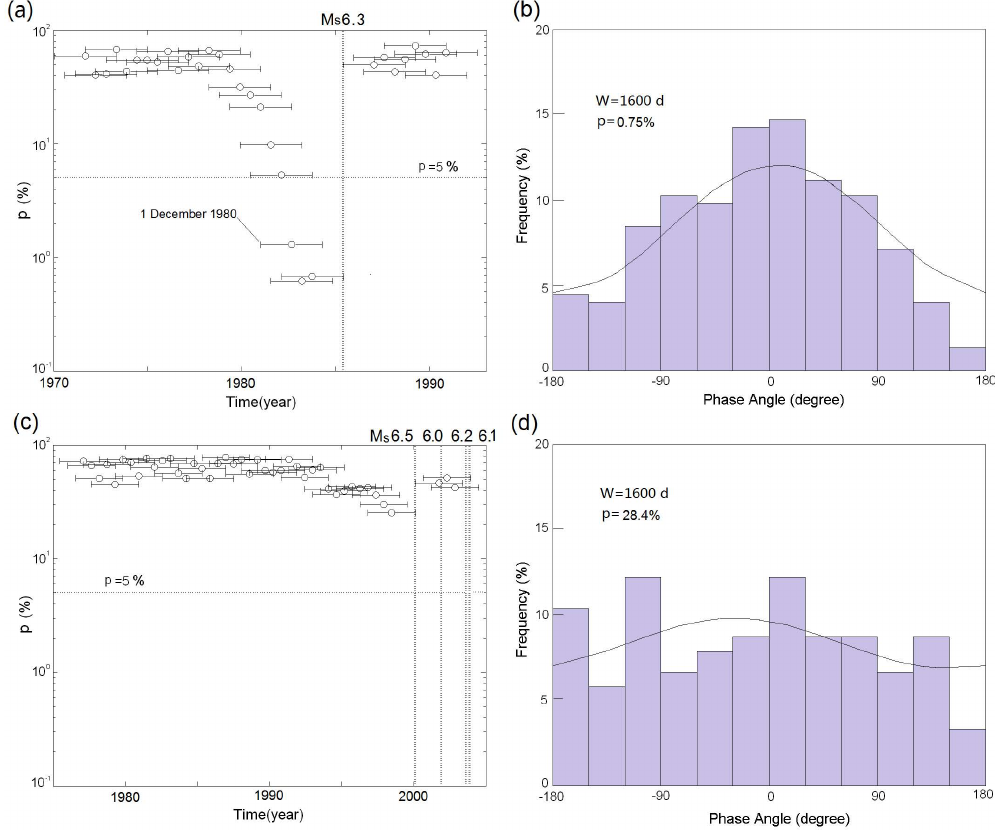
Fig. 8. (a) Variation of p value with time in the Luquan region. The time window length, indicated by a horizontal line, is 1200 days, and the step length is 200 days. (b) Phase angle frequency change for events during the period of 1600 days before the Luquan M s = 6.3 earthquake. The fine solid curve signifies a sinusoidal function which corresponds to the least square fit to the change. The fitting time window is a full period of sinusoidal function. (c) Variation of p value with time in the Yaoan region. The time window length, indicated by a horizontal line, is 1200 days, and the step length is 200 days. (d) Phase angle frequency change for events during the period of 1600 days before the Yaoan M s = 6.5 earthquake. The fine solid curve signifies a sinusoidal function which corresponds to the least square fit to the change. The fitting time window is a full period of sinusoidal